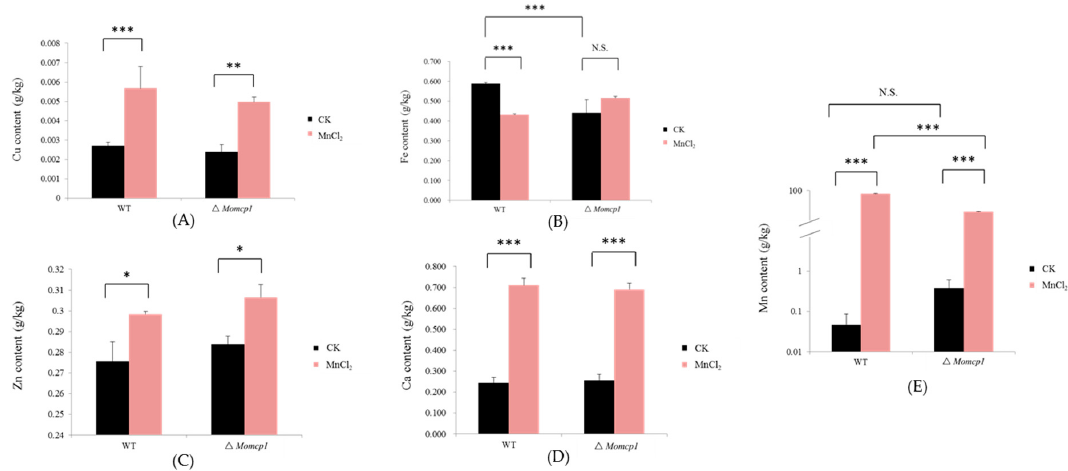
Figure 5. The contents of different metals in the WT and ∆ Momcp1 mutant under 2 mM Mn 2+ . The contents of Cu ( A ), Fe ( B ), Zn ( C ), Ca ( D ), and Mn ( E ) in the WT and ∆ Momcp1 mutant. The significant differences determined by the Tukey-HSD test; *, p < 0.05; **, p < 0.01; ***, p < 0.001; N.S, no